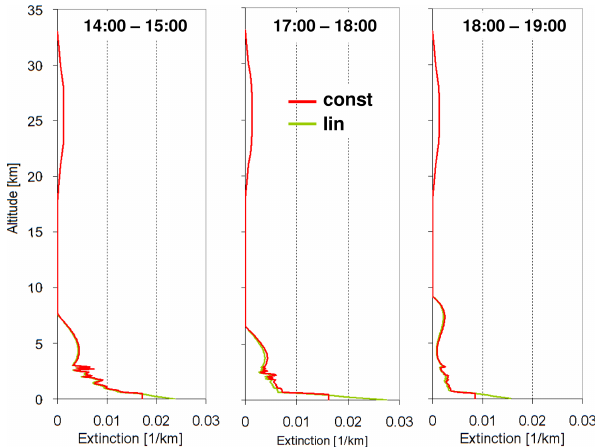
Figure 5. Complete aerosol extinction profiles for the three time periods without clouds after all corrections are applied. The green curves represent the profiles with linear extrapolation below 500m; the red curves represent profiles with constant values below